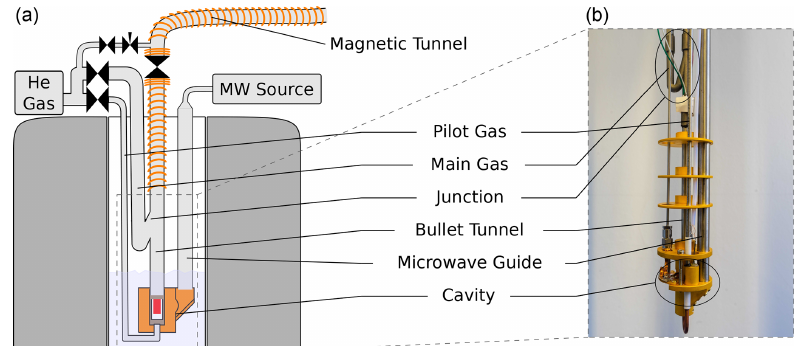
Figure 1. Sketch (a) and photograph (b) of the DNP insert. The figure has been adapted from Kouˇril et al. (2019). In contrast to the previous design, the new insert uses not one but two lines to supply the helium gas used to propel the sample: a 1 / 8 (cid:48)(cid:48) line (pilot gas) is used to lift the sample out of the isothermal zone of the cryostat. A substantially larger flow is then applied via a 1 / 4 (cid:48)(cid:48) line (main gas). This line is connected to the bullet tunnel via a 3D printed junction in such a way that the helium flow is directed upwards as it enters the bullet tunnel.